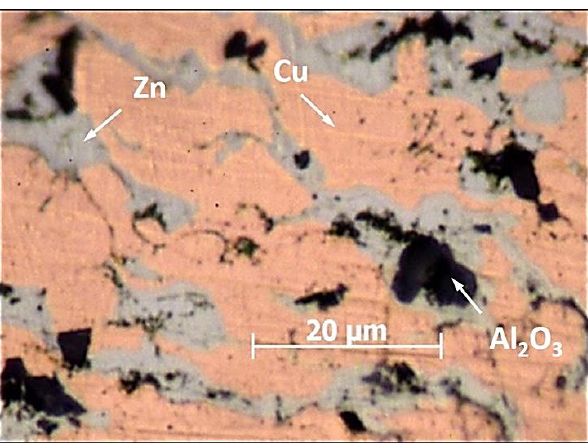
Figure 2. The microstructure of cold sprayed Cu-Zn-Al 2 O 3 powder blend.